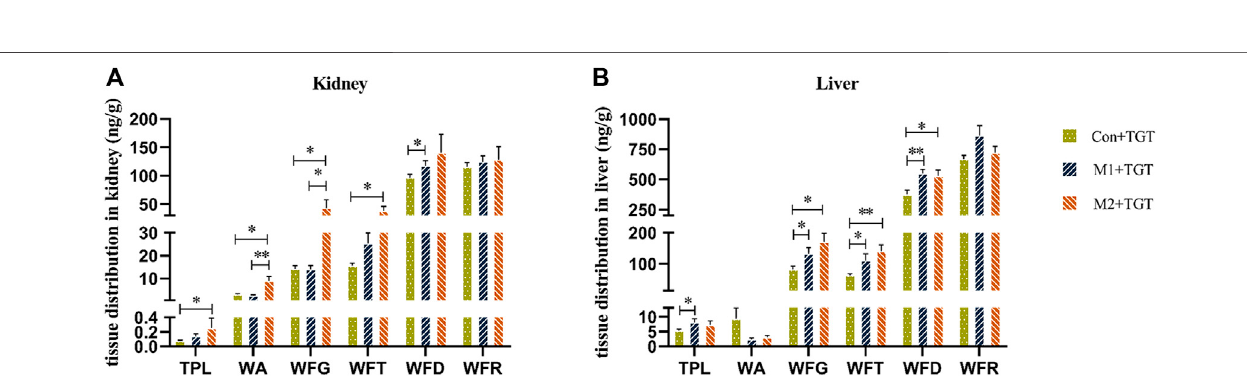
FIGURE7| TissuedistributionsofthesixkeyTGTcomponentsinthenormalandtwotypesofadriamycin-induced-NSrats1 hourfollowingthelastdoseafterTGT oralgavagedoseof10 mg/kg/dayfor4 weeks(means ±SD, n =7). Con+TGT,thenormalrats; M1+TGT,theearly-stage NSrats;M2+TGT,theadvanced-stageNS rats. Kidney (A) , Liver (B) , p p < 0.05, pp p < 0.01 versus Con + TGT or M1+TGT.